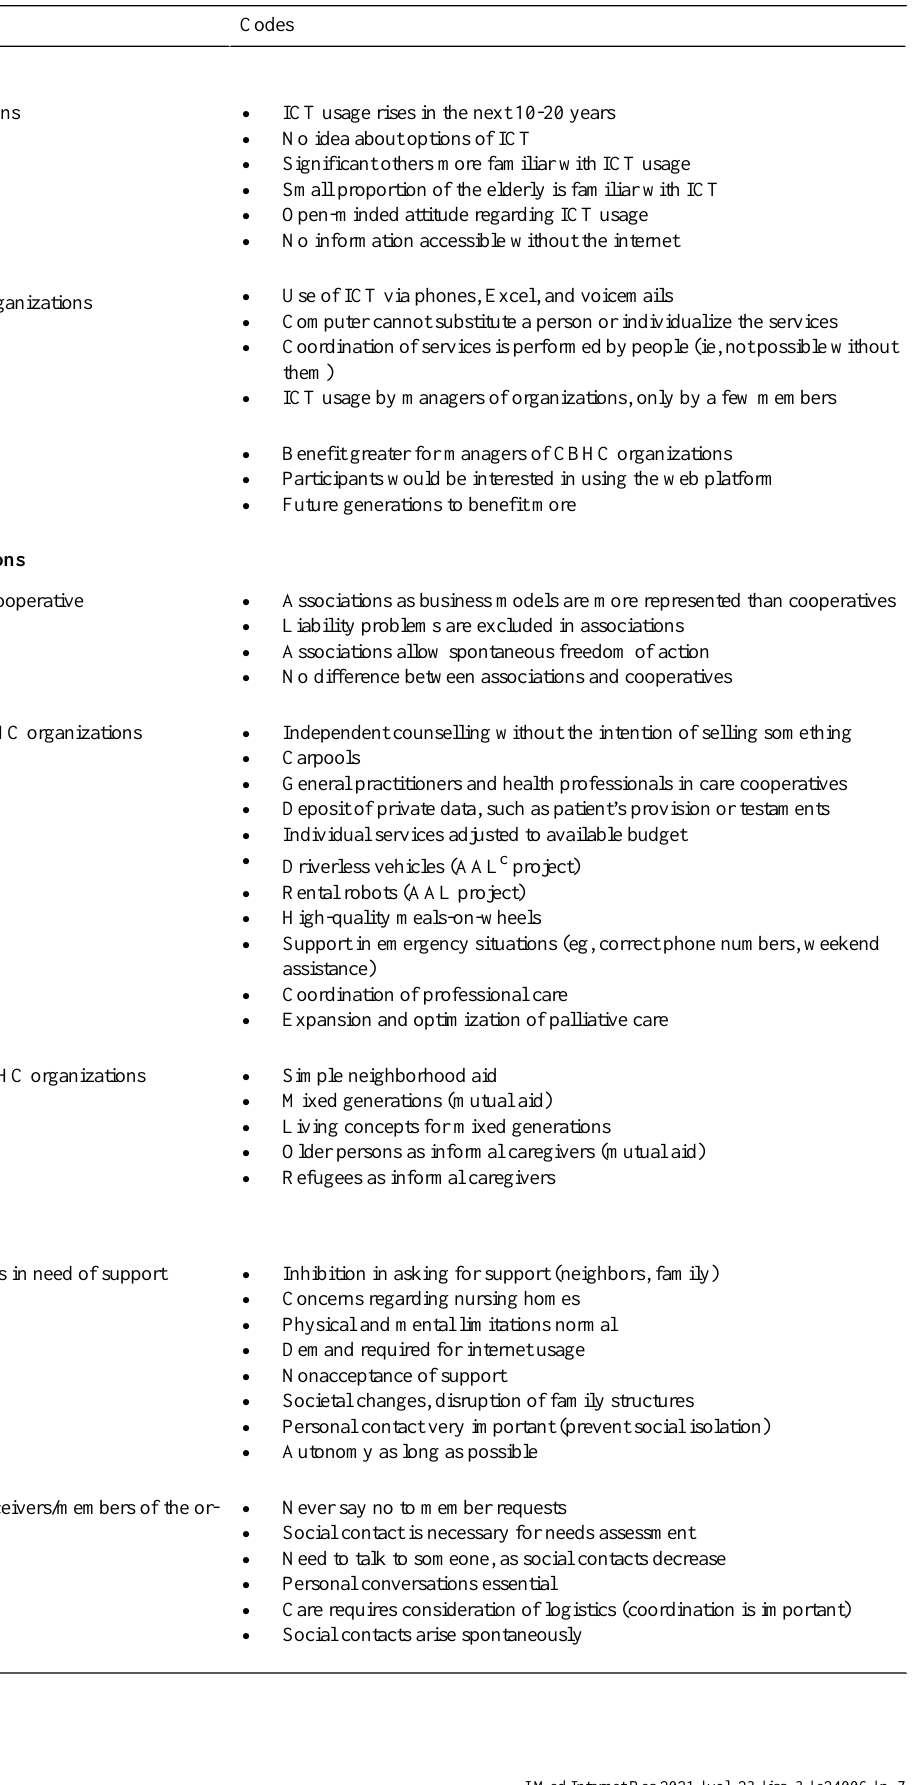
Table 3. Subcategories and codes of three of the five main categories extracted from the study